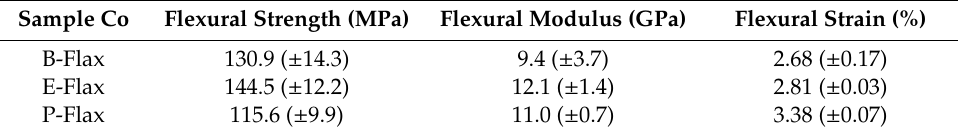
Table 4. Flexural properties of flax tape composites.